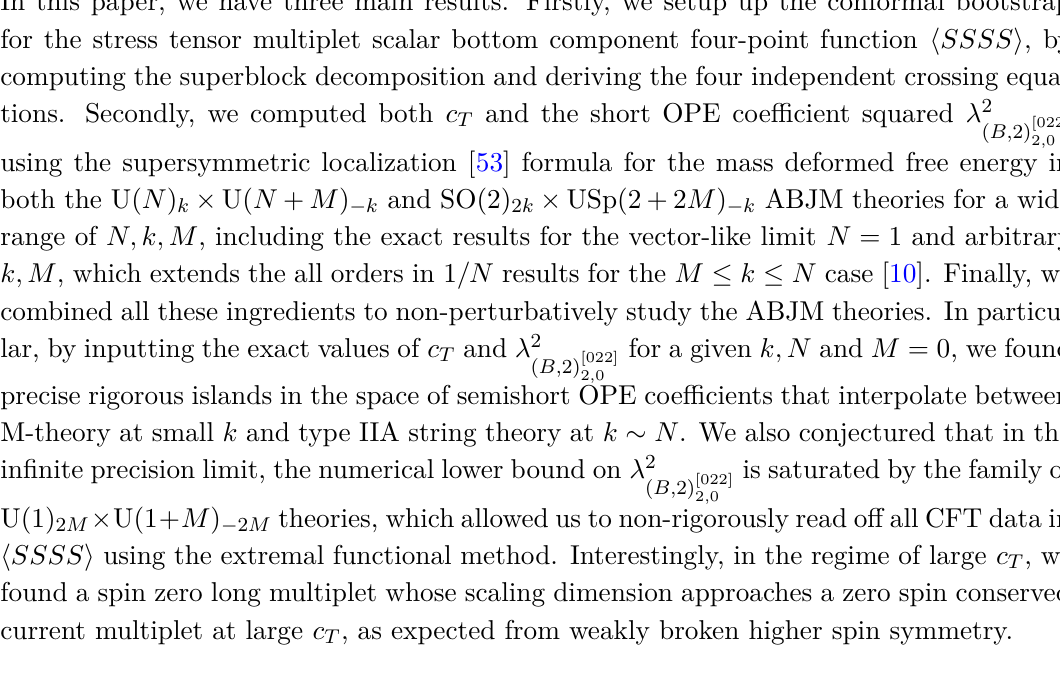
Figure 8 . Islands in the space of the semi-short OPE coefficients λ 2 fined precisely later) for U( N ) k × U( N ) − k ABJM theory for various N, k . These bounds are derived from the N = 6 bootstrap with Λ = 39 derivatives, and with the short OPE coefficients (i.e. c T and λ 2 ) fixed to their values in each theory using the exact localization results of [9] for N = 2 , 3 , 4 ( B, 2) [022] 2 , 0 as shown in table 9 and the all orders in 1 /N formulae in [10] for N = 10 as shown in table